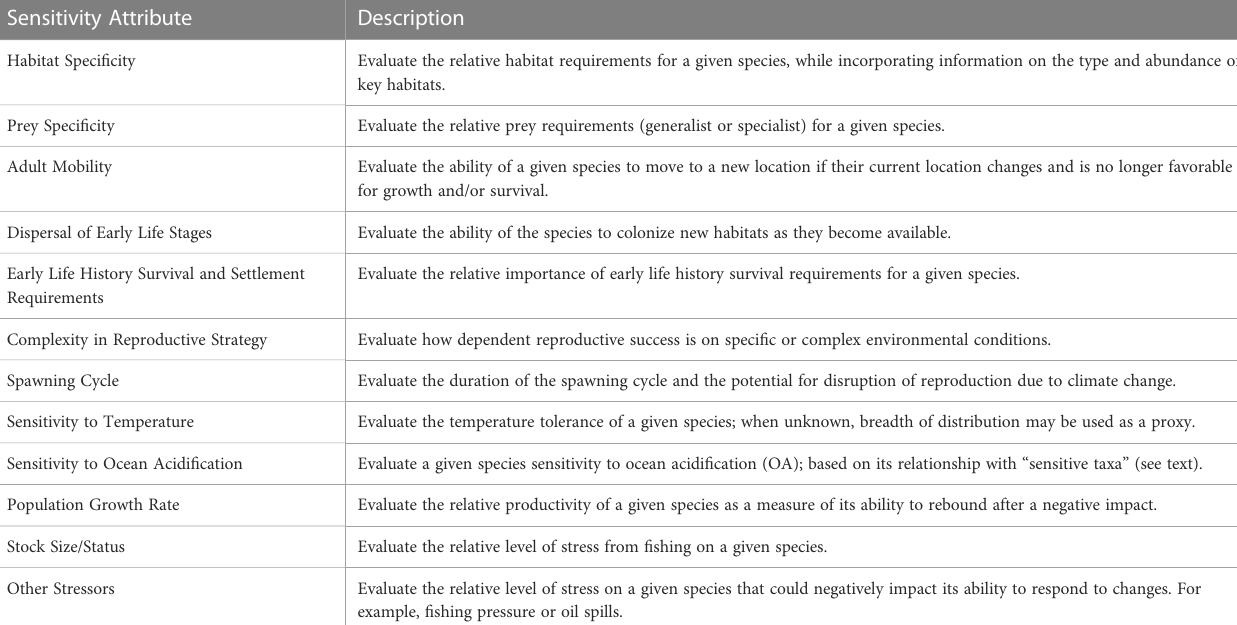
TABLE 2 List of the twelve sensitivity attributes used in this study (from Morrison et al.,